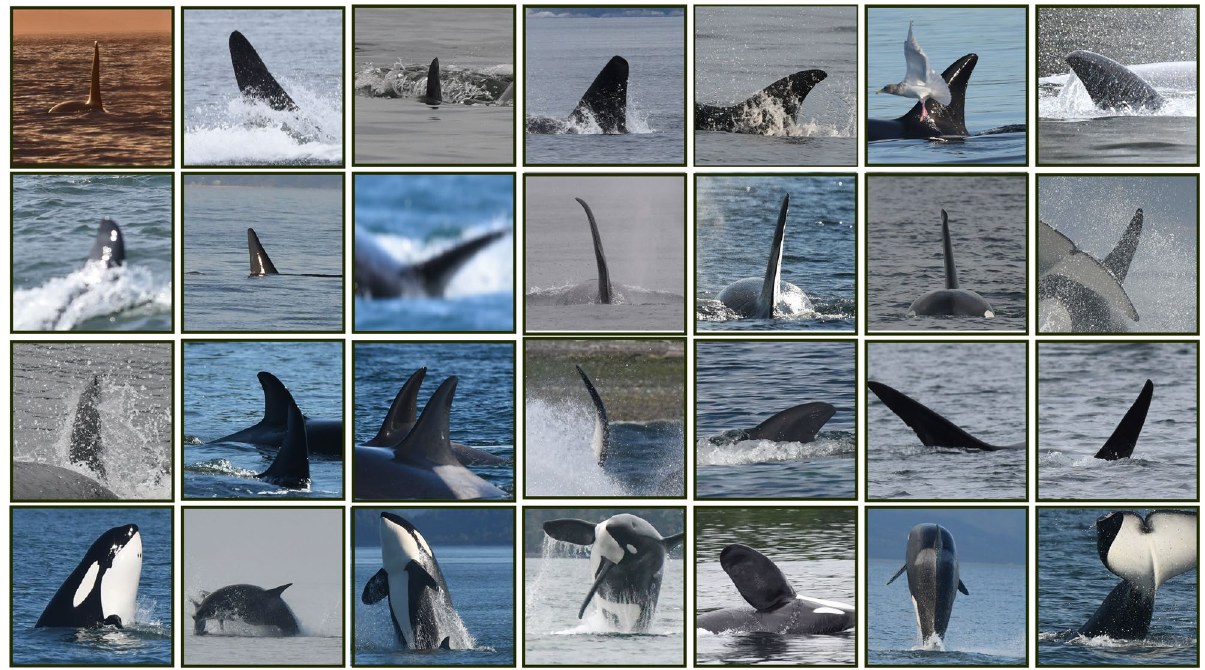
Figure 5. Detected (FIN-DETECT) and extracted (FIN-EXTRACT) unseen identification images from 2018, which were successfully categorized and filtered as invalid identification images by VVI-DETECT, trained on VIKWID11-17, reported in Table 2.